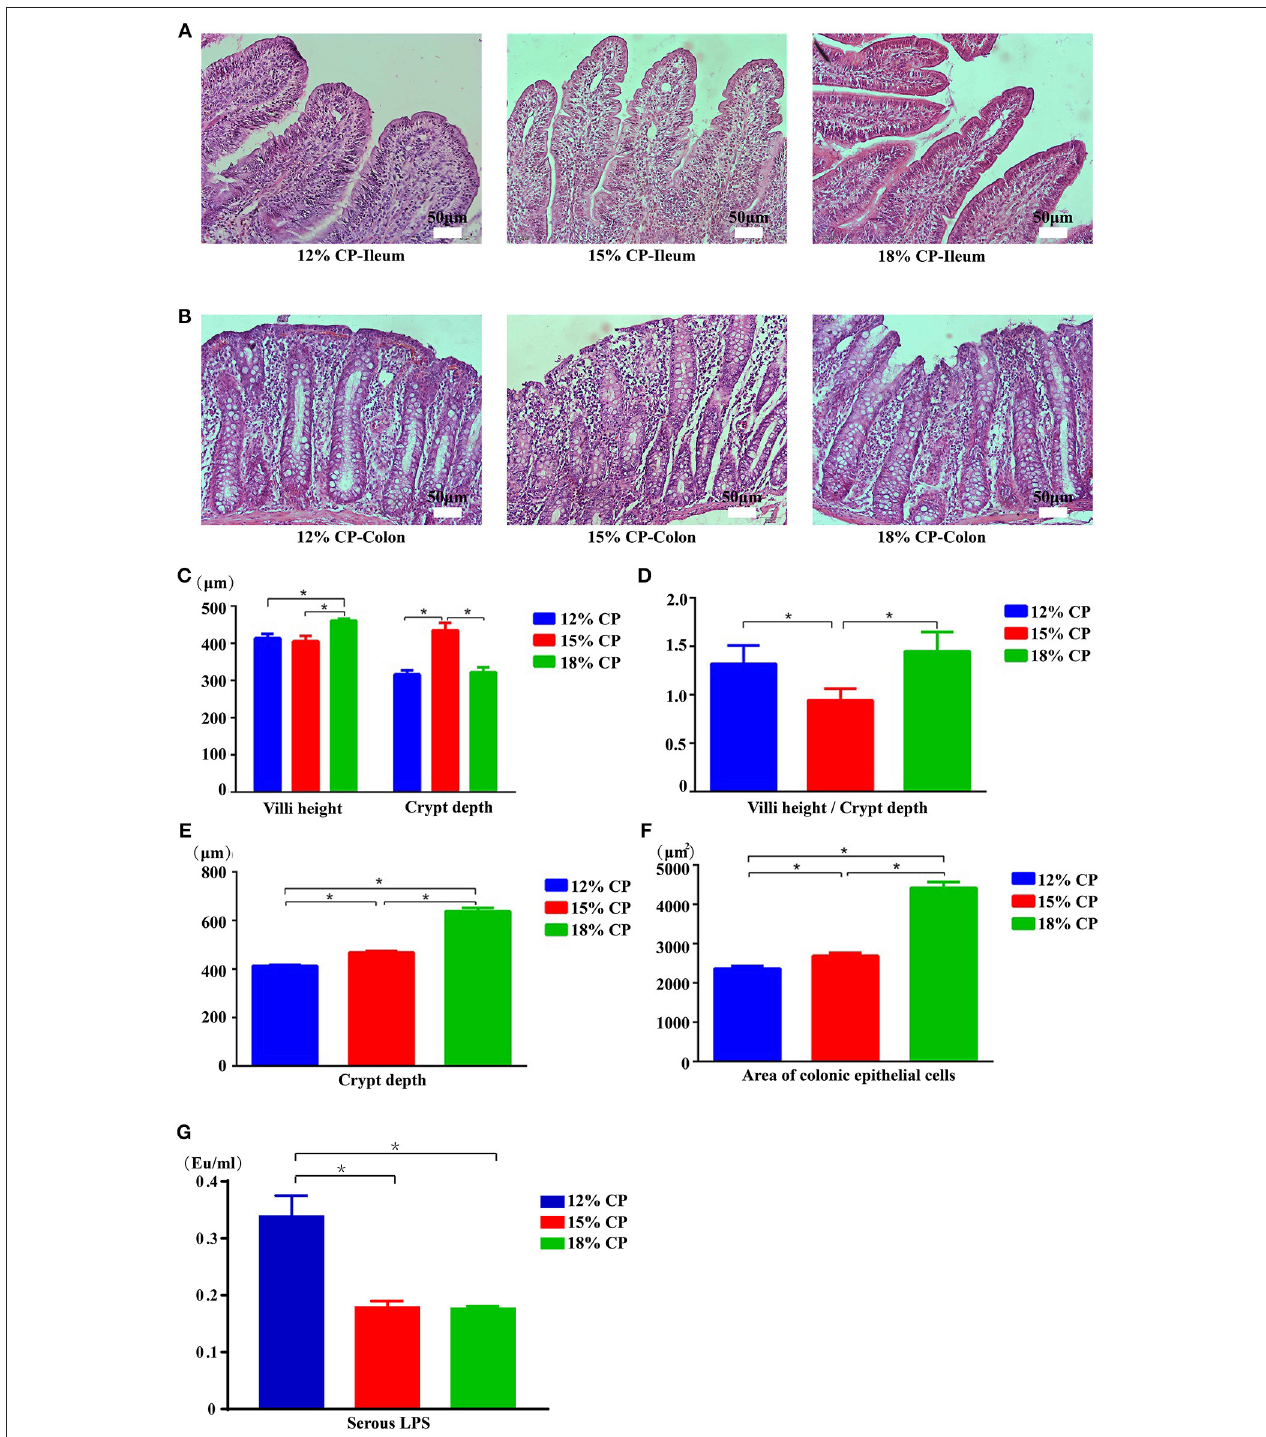
FIGURE 5 | Effects of low-protein diets on intestinal mucosal morphology and permeability of growing pigs (the stained sections were photographed at 200 × magnification). (A) Ileal morphology observation of different dietary protein groups. (B) Colonic morphology observation of different dietary protein groups. (C) Villi height and crypt depth of the ileum. (D) Villi height to crypt depth ratios in the ileum. (E) Colonic crypt depth. (F) Area of colonic epithelial cells. (G) Lipopolysaccharide (LPS) level in the serum. Values are means ± standard deviations ( n = 6). Star indicates a significant difference ( P < 0.05).